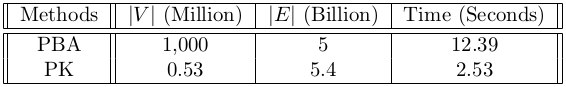
Table from the paper: Parallel Generation of Massive Scale-Free Graphs
Table text:
Methods
| V | (Million)
| E | (Billion)
Time(Seconds)
PBA
1,000
5
12.39
PK
0.53
5.4
2.53